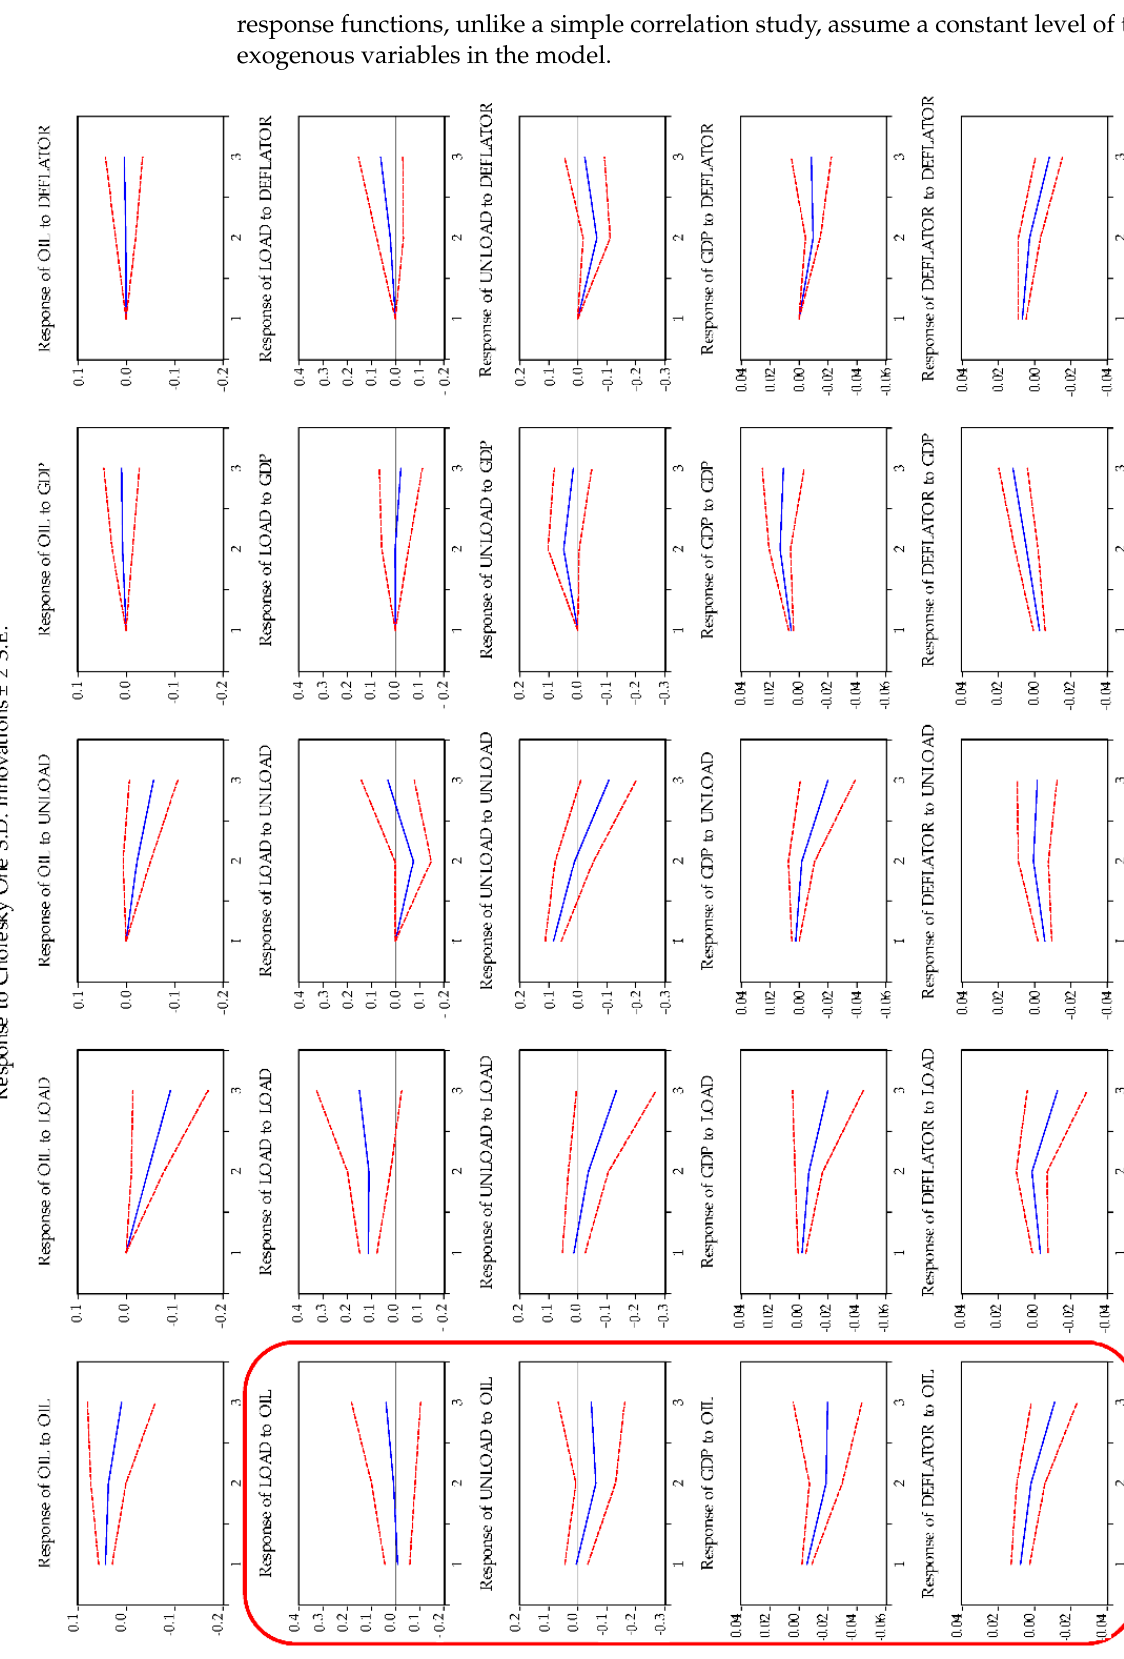
Figure 2. Impulse response functions: levels of variables (model A). Red line—95% confidence